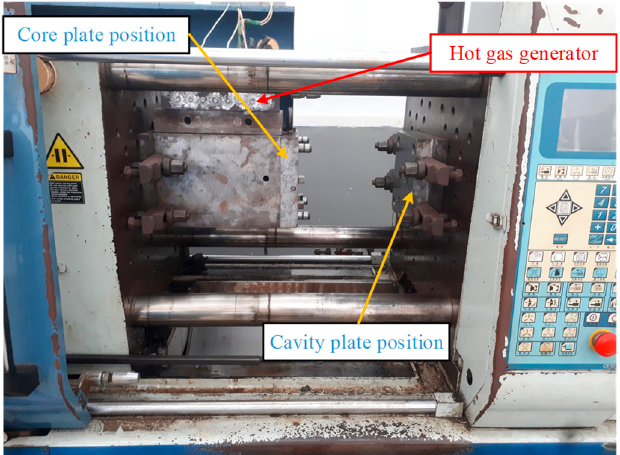
Figure 3. The experiment model for the In-GMTC.